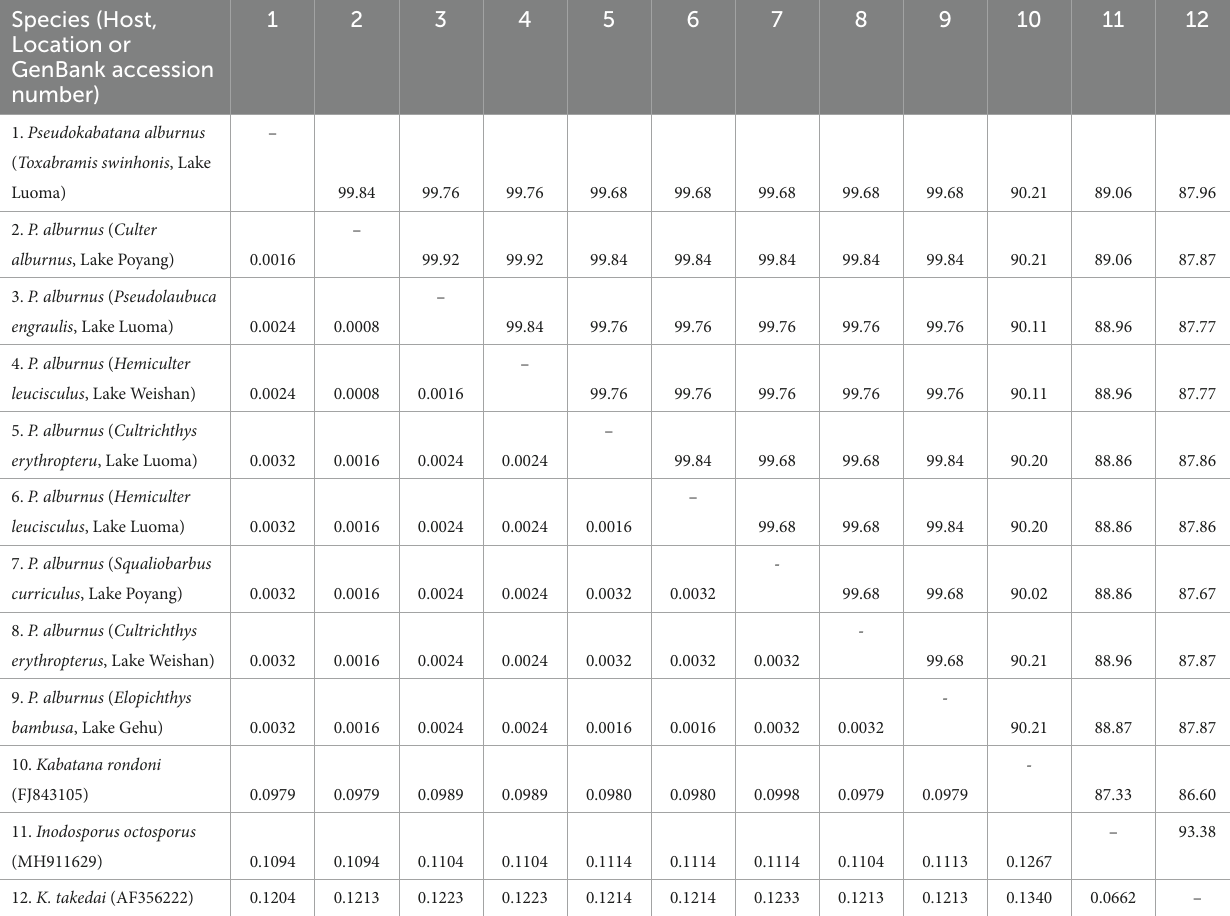
TABLE 3 Pairwise nucleotide sequence identity (upper right) values and evolutionary distances (left bottom) among Pseudokabatana alburnus isolates and 3 other microsporidian species with high sequence similarity by Kimura-2 Parameter analysis based on SSU rDNA sequences. Species (Host, Location or